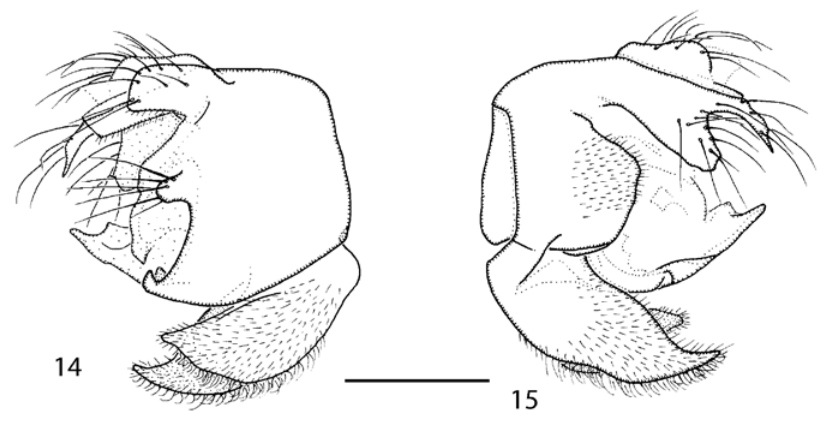
Fig. 12. Rhynchomicropteron species 1 male, frons